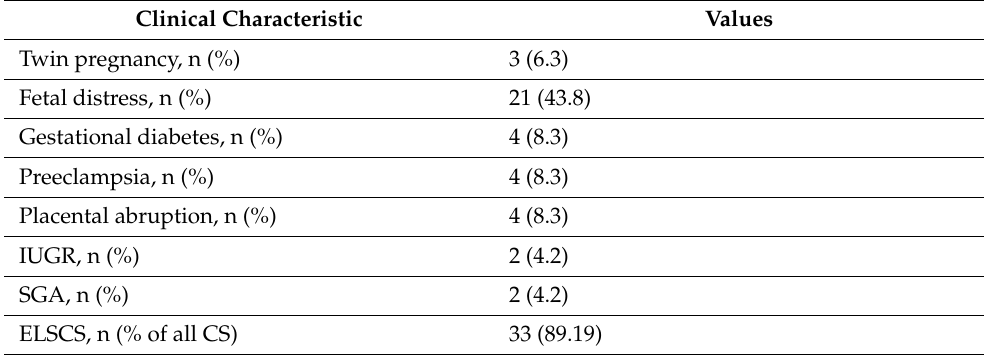
Table 2. Clinical characteristics of the neonates with RDS and laboratory findings at baseline (N =